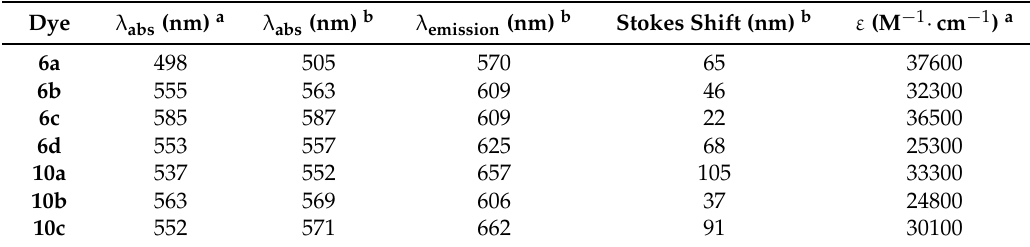
Table 1. Spectral Characteristics of Dyes 6a – d and 10ac